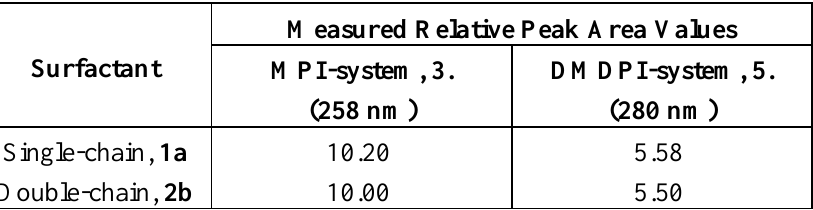
Table 3 . Comparison of peak areas of single- and double-chain